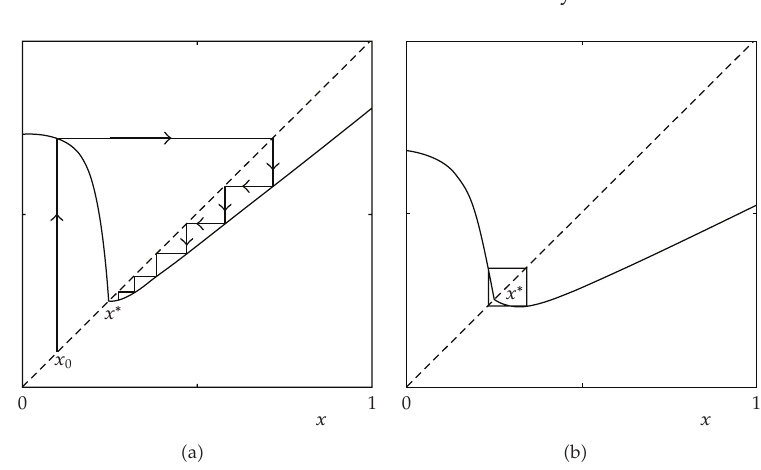
Figure 3: Same payo ff functions as in Figure 2 (cid:2) a (cid:3) δ A (cid:7) 0 . 8, δ B (cid:7) 0 . 2, λ (cid:7) 30, f (cid:7) − (cid:2) x ∗ (cid:3) < − 1 and 0 < f (cid:7) (cid:8) (cid:2) x ∗ (cid:3) < 1. (cid:2) b (cid:3) δ A (cid:7) 0 . 8, δ B (cid:7) 0 . 5, λ (cid:7) 17, f (cid:7) − (cid:2) x ∗ (cid:3) < − 1 and f (cid:7) (cid:8) (cid:2) x ∗ (cid:3) < 0 such that f (cid:7) − (cid:2) x ∗ (cid:3) f (cid:7) (cid:8) (cid:2) x ∗ (cid:3) >